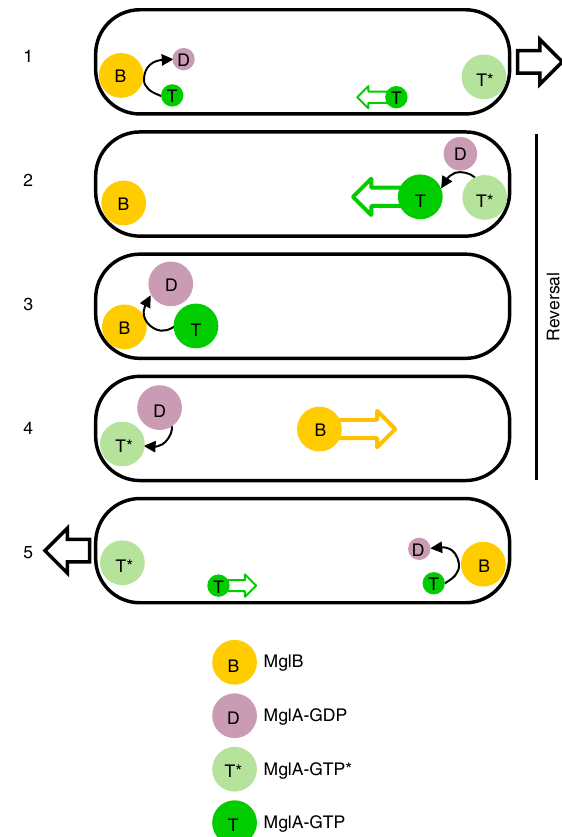
Fig. 5 Model of the three-state MglA switch. 1 The MglA-GTP cluster located at the front pole of the gliding bacteria is composed of a major species stably associated to the pole which is resistant to MglB (MglA- GTP*, T* in kaki) and a minor diffusible species (MglA-GTP, T, in green) that can reach the lagging pole to be inactivated into MglA-GDP (D in mauve) by MglB (B, in orange). 2 During a reversal event, MglA-GDP is released in the cytosol to reach the leading pole where it converts all polar MglA-GTP* into diffusible MglA-GTP, which detaches rapidly from the pole. 3 MglA-GTP is rapidly inactivated into MglA-GDP by MglB at the lagging pole. 4 MglA-GDP is reloaded with GTP by a GEF activity to regenerate MglB-resistant MglA-GTP*, and MglB relocates to the opposite pole. 5 A new leading pole is established, resuming movement in the opposite direction. The direction of movement at steps 1 and 5 is shown by a black arrow, the reversal event spanning steps 2 − 3 − 4 is indicated by a vertical